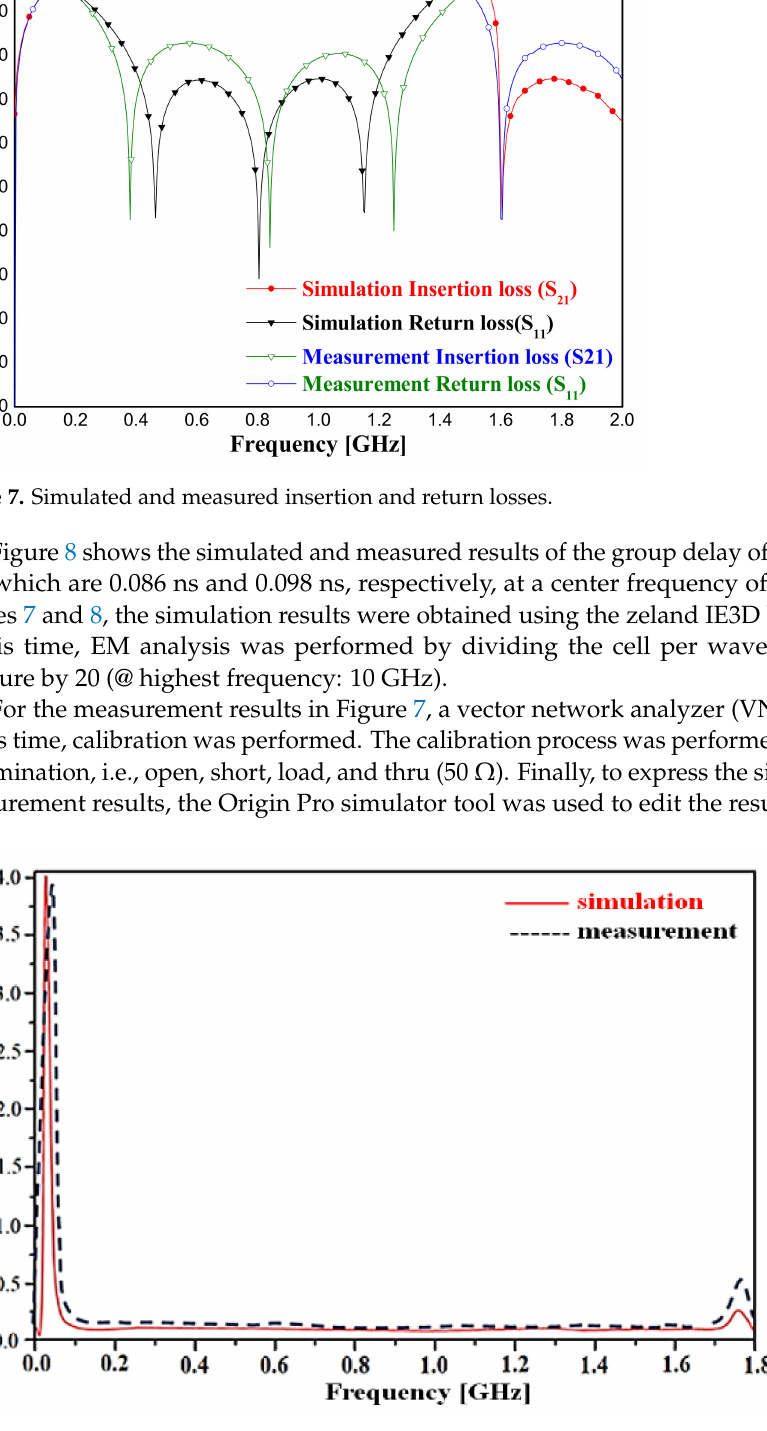
Figure 8. Simulated and measured group delays of the designed